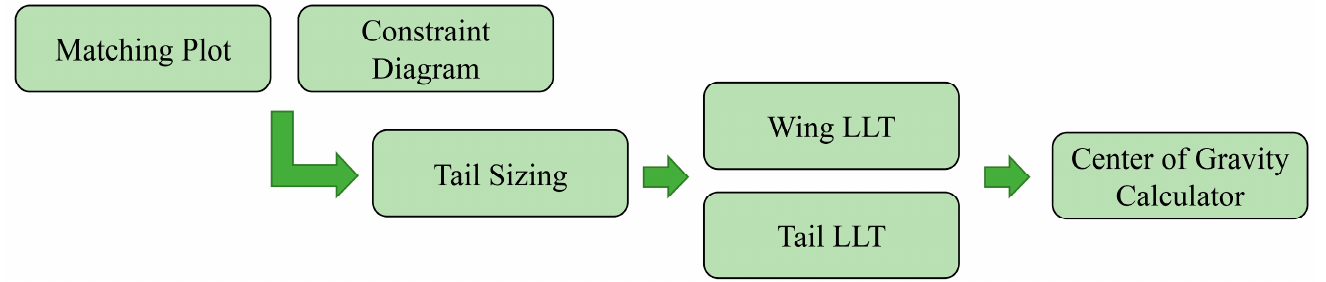
Figure 2. MataMorph-3 Design and Sizing application flowchart .